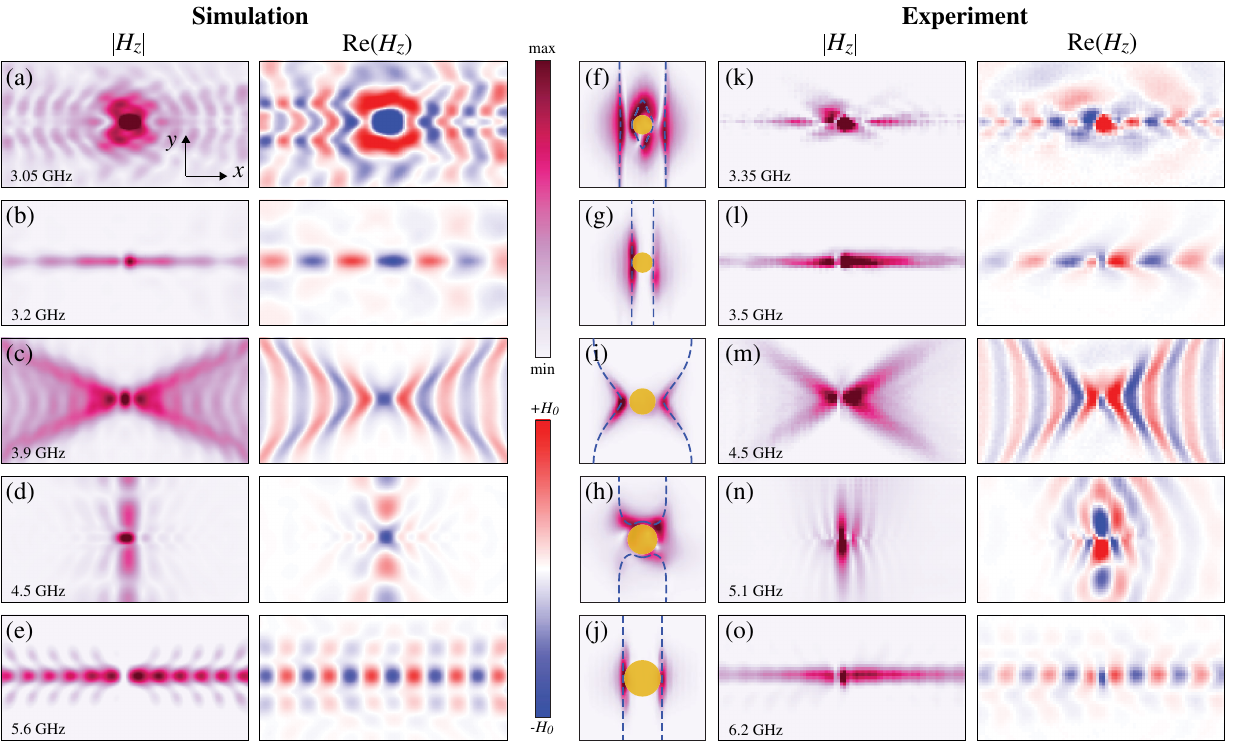
FIG. 8. Spatial distribution of the absolute value (first and fourth columns) and real part (second and fifth columns) of the normal magnetic field component of quasi-TE surface waves calculated numerically (a) – (e) and measured (k) – (o). The scanning area of the structure consists of 48 × 24 unit cells ( 336 × 168 mm 2 ). The central column (f) – (j) corresponds to the isofrequency contours within the first Brillouin zone restored from the measurements (color maps) and calculated numerically with the CST eigenmode solver (blue dashed lines).